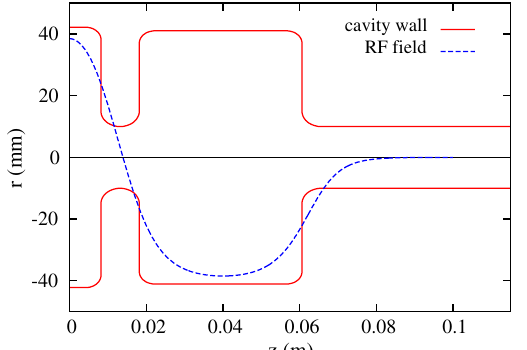
FIG. 4. Amplitude of electrical field and average beam current vs time during a macropulse. Here (cid:5) ¼ 0 : 33 (cid:8) s .